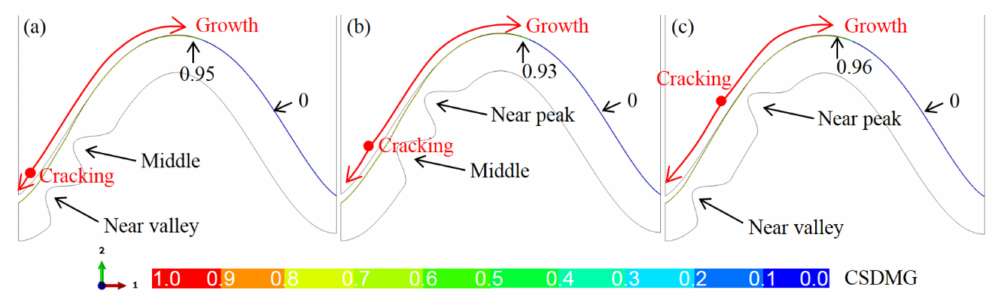
Figure 14. The CSDMG distributions in the ceramic layer under different locations of two bulges ( N = 20, at room temperature): ( a ) near valley and middle, ( b ) middle and near peak, and ( c ) near valley and